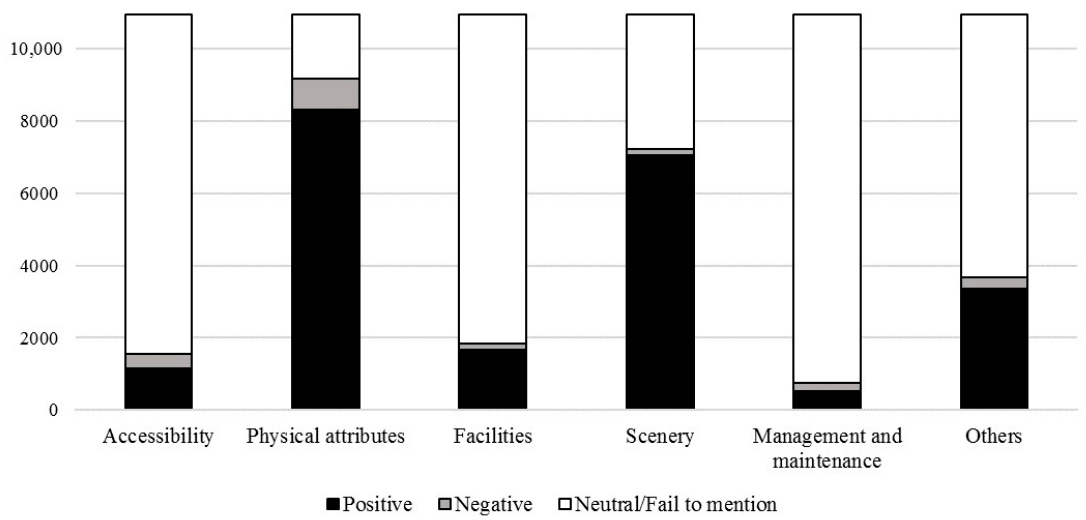
Figure 6. The number of online comments assigned to positive, negative and neutral emotions/fail to mention each factor category.